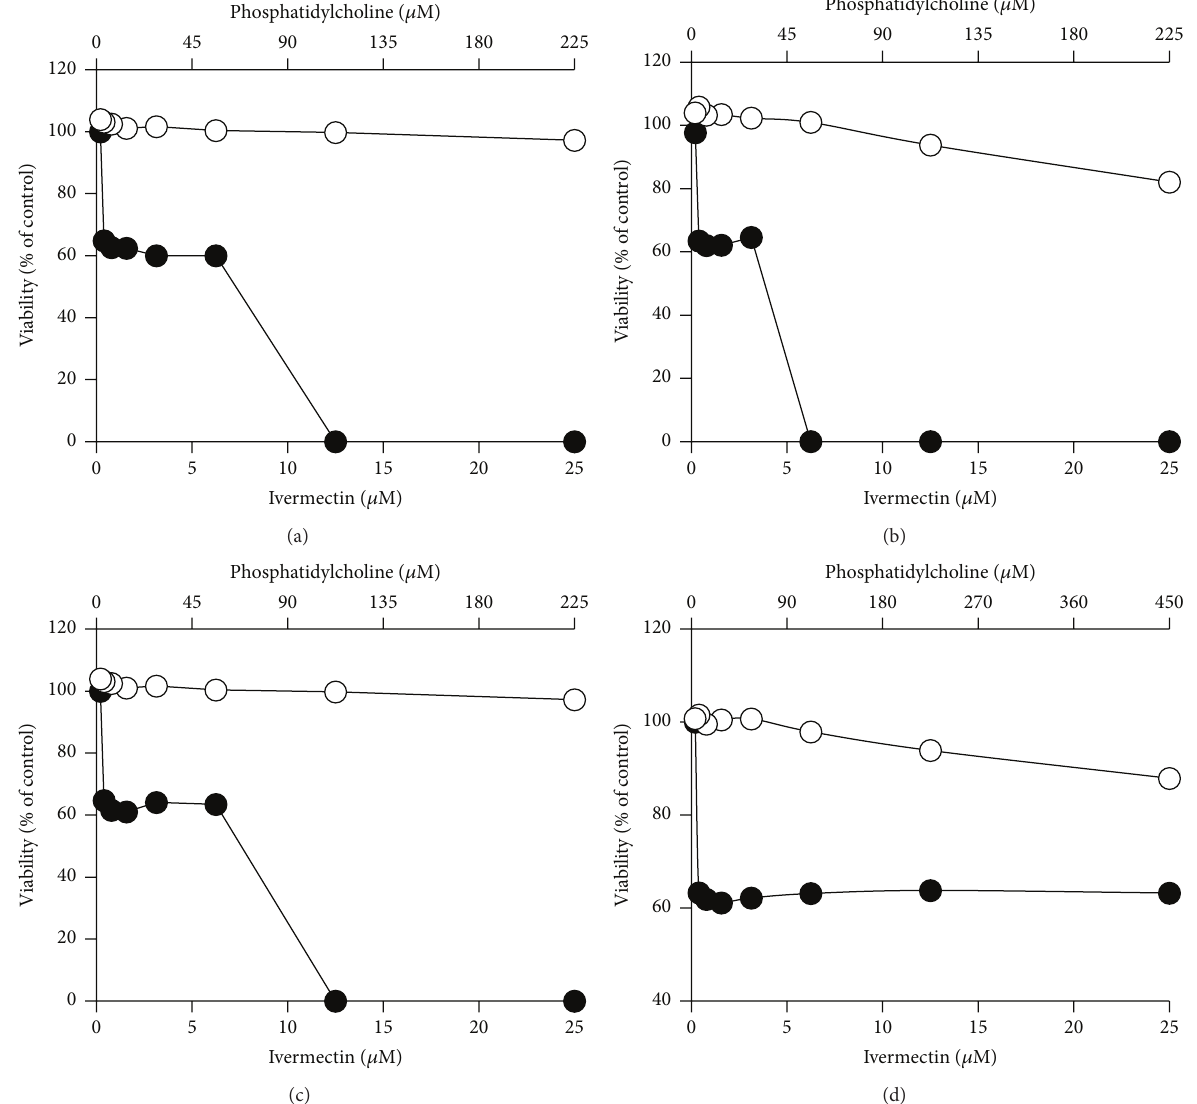
Figure 9: In vitro cytotoxicity effect of ivermectin formulated in liposomes (closed circles) on BHK cells. For comparison the same experiments were performed using empty liposomal formulations (open circles). The following liposomal formulations were tested: #PC9- Ch1 and #PC9-Ch1-ive1.0 (a), #PC9-Br1 and #PC9-Br1-ive1.0 (b), #PC9-Br0.5 and #PC9-Br0.5-ive1.0 (c), and #PC18-Br1 and #PC18-Br1-ive1.0 (d). The phosphatidylcholine concentration (top 𝑥 -axis) is related to empty liposomes while the ivermectin concentration (bottom 𝑥 -axis) is related to ivermectin liposomes. Details on the identification codes and liposomal compositions are included in Table 1. Data represent the average of 2